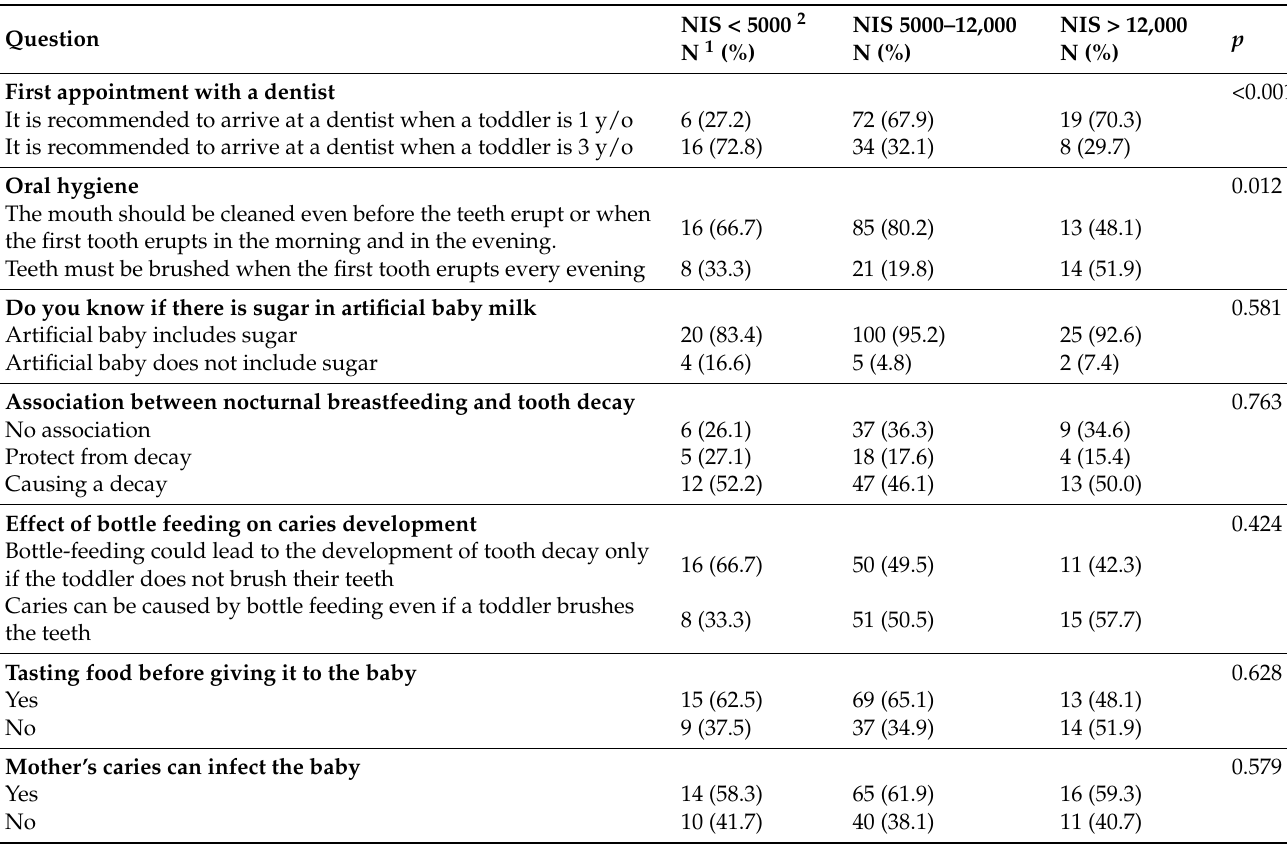
Table 5. Comparison between mothers according to income levels in knowledge about caries preven- tion and the health of their toddlers’